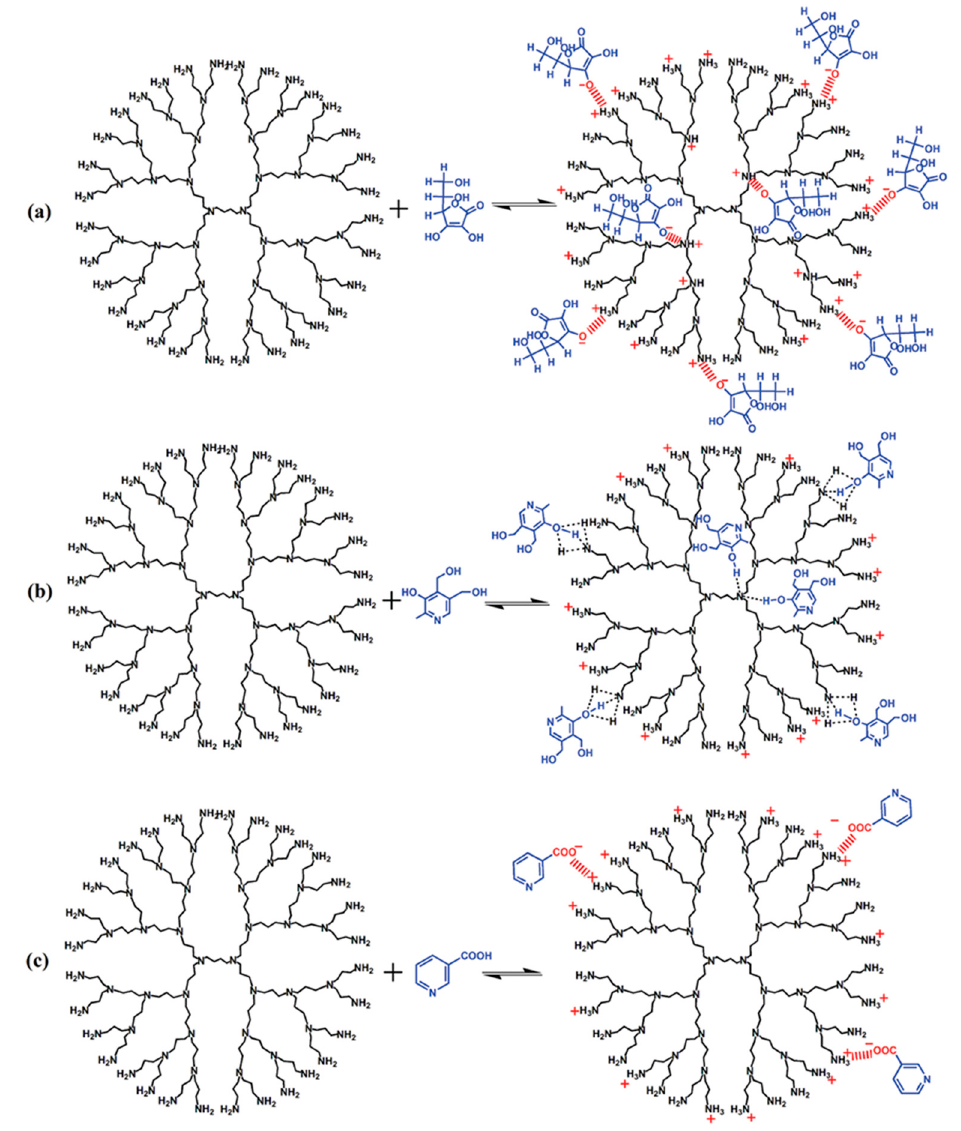
Figure 49. Complexation of G3, Poly(propyleneimine) (PPI) dendrimer with ( a ) Vitamin C, ( b